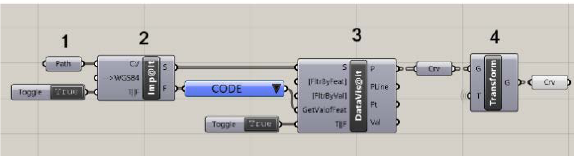
Figure 6. Instructions of the macro using Shapefiles